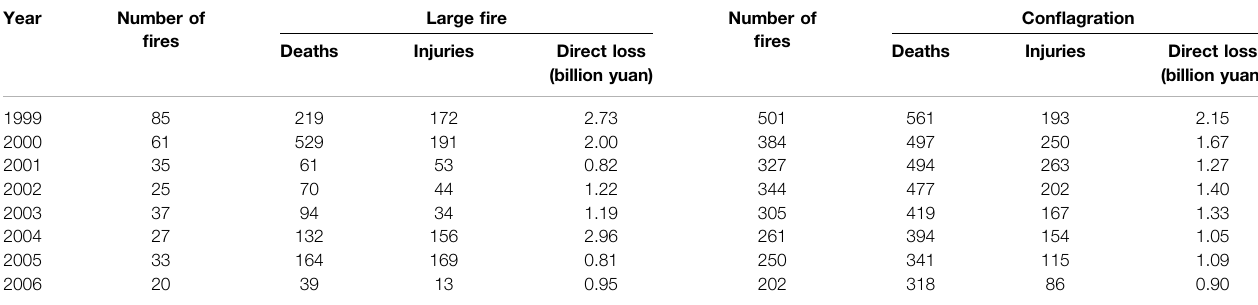
TABLE 4 | Details of the different levels of serious fi res from 1999 to 2006.